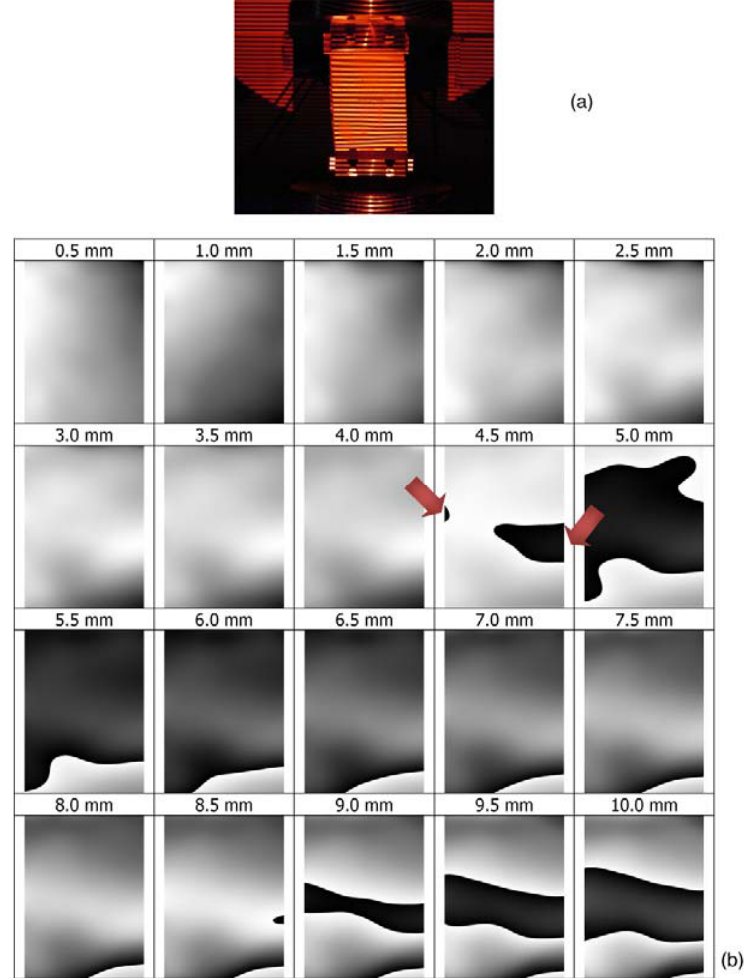
Figure 6. ( a ) Pattern of fringes projected by the bottom projector onto the loaded sample 2; ( b ) evolution of total phase difference, Δ (cid:2038) and ( c ) measured out-of-plane displacements along the AB control path for different levels of end-shortening given to the